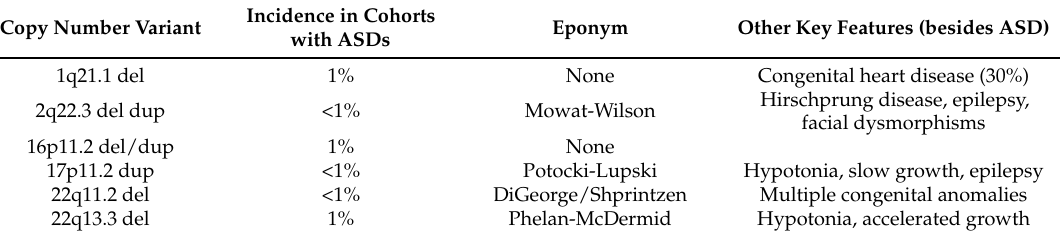
Table 2. “Autism Syndromes” Identified by Chromosomal